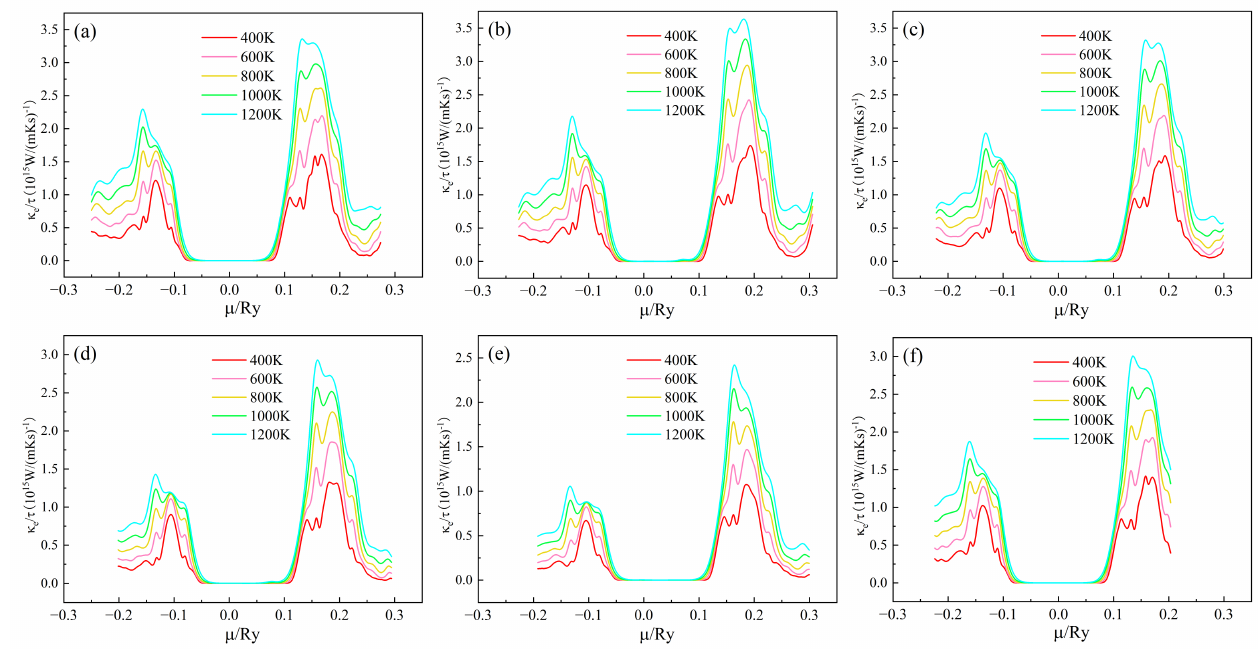
Figure 6. Chemical potential dependent of κ e / τ of (Sr 0.889-x La 0.111 Bi x )TiO 2.963. ( a ) Sr 0.889 La 0.111 TiO 2.963; ( b ) Sr 0.852 La 0.111 Bi 0.037 TiO 2.963; ( c ) Sr 0.815 La 0.111 Bi 0.074 TiO 2.963; ( d ) Sr 0.778 La 0.111 Bi 0.111 TiO 2.963; ( e ) Sr 0.741 La 0.111 Bi 0.148 TiO 2.963; ( f ) Sr 0.815 La 0.185 TiO 2.963 . The power factor/relaxation time of the (Sr 0.889-x La 0.111 Bi x )TiO 2.963 varies with